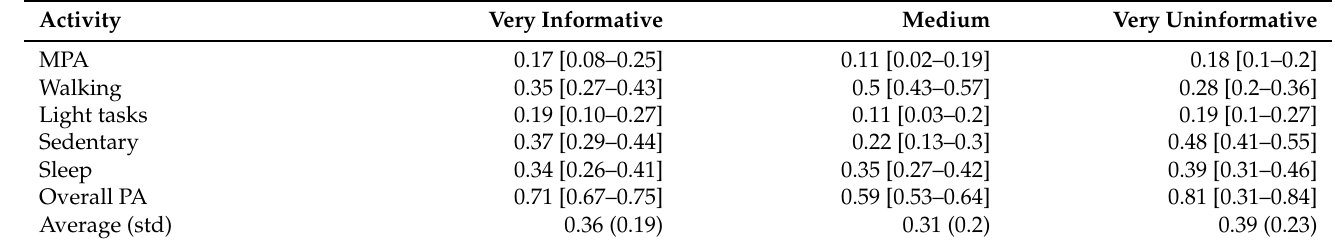
Table 5. Effect of activities durations prior on the correlation between time spent in activities as estimated by our unsupervised HSMM-based classification and by the supervised method of Willetts et al. [7]. Data presented as Pearson’s correlation coefficients and 95% confidence intervals, unless otherwise